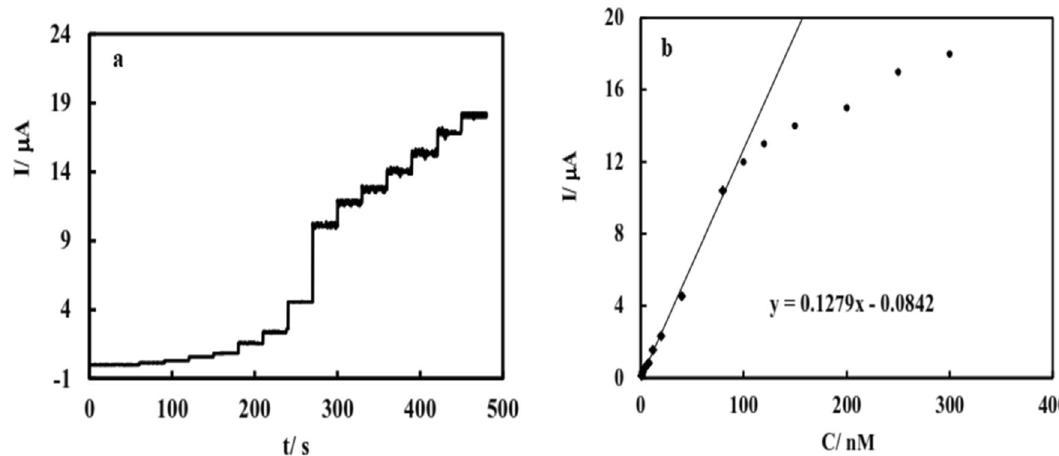
Figure 8. ( a ) Hydrodynamic amperograms of N, S-GQD/GCE immersed in stirred solution of KNO 3 applying 0 V adding different amounts of Fe(III); Variation of current versus concentration obtained from presented hydrodynamic amperometry.